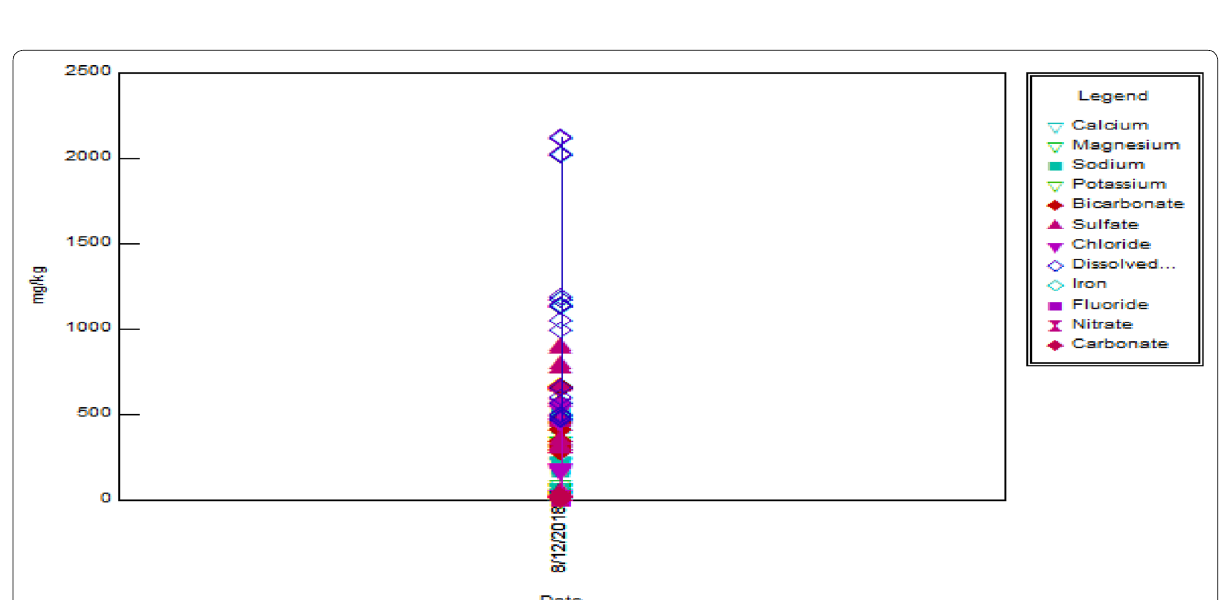
Fig. 8 Time series plot display the hydrological facies of the borehole